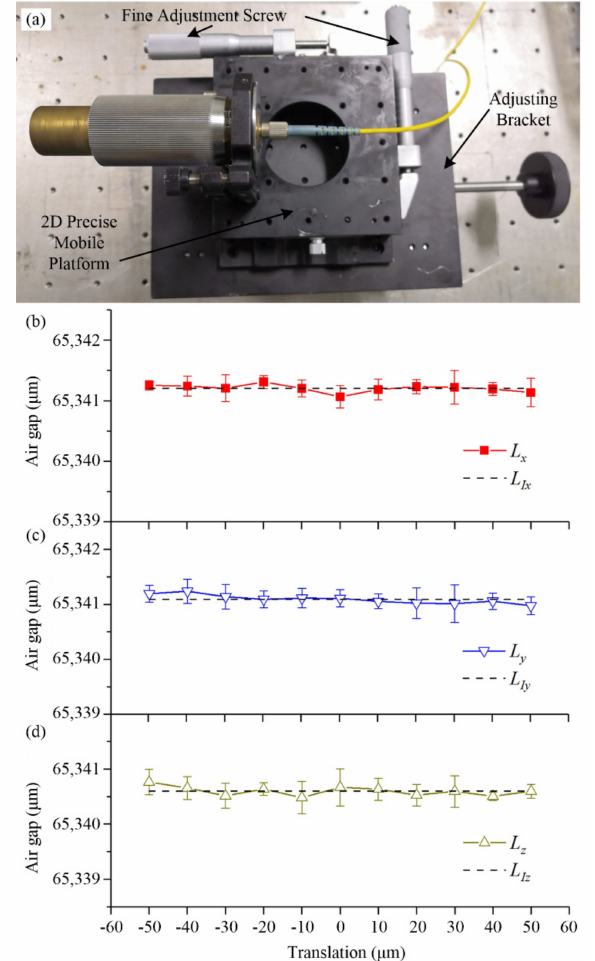
Figure 7. Measurement results after artificial additional translation. ( a ) The translation adjustment device. ( b ) Measurement results after x -axis translation. “ L x ” is the length of the air gap after x -axis translation. ( c ) Measurement results after y -axis translation. “ L y ” is the length of the air gap after y -axis translation. ( d ) Measurement results after z -axis translation. “ L z ” is the length of the air gap after z -axis translation. The dashed lines are the initial length of the air gap before